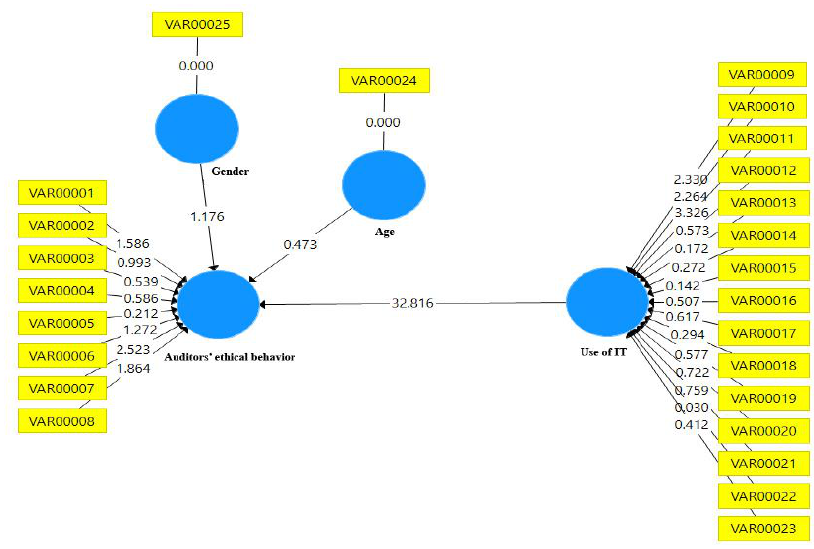
Fig. 2. PLS method of the general research